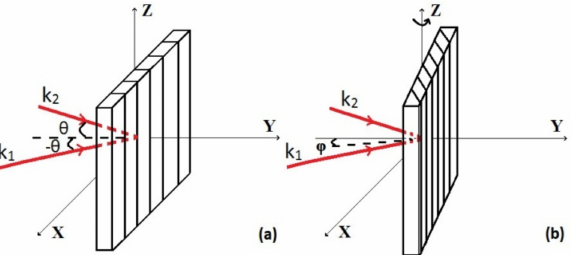
Figure 1. Schemes for recording ( a ) nonslanted and ( b ) slanted holographic gratings. k 1 and k 2 are vectors of incident waves, θ is the angle of incidence, and φ is the angle of rotation of the sample. Industrial photopolymer materials Bayfol HX (Covestro AG) on a film base [12]